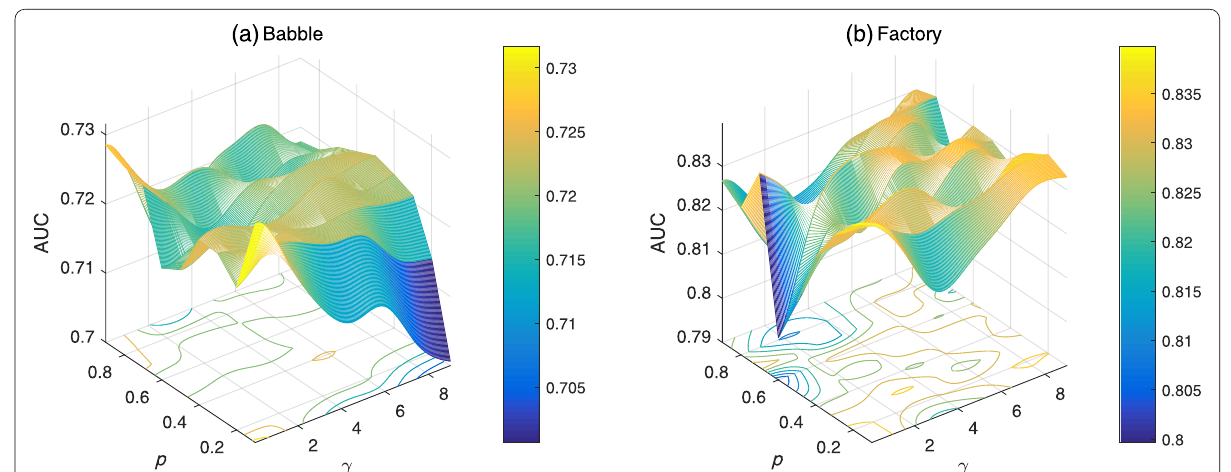
Fig. 6 Effect of the hyperparameters γ and p of MaxAUC hinge VAD on the Chinese development dataset at − 5